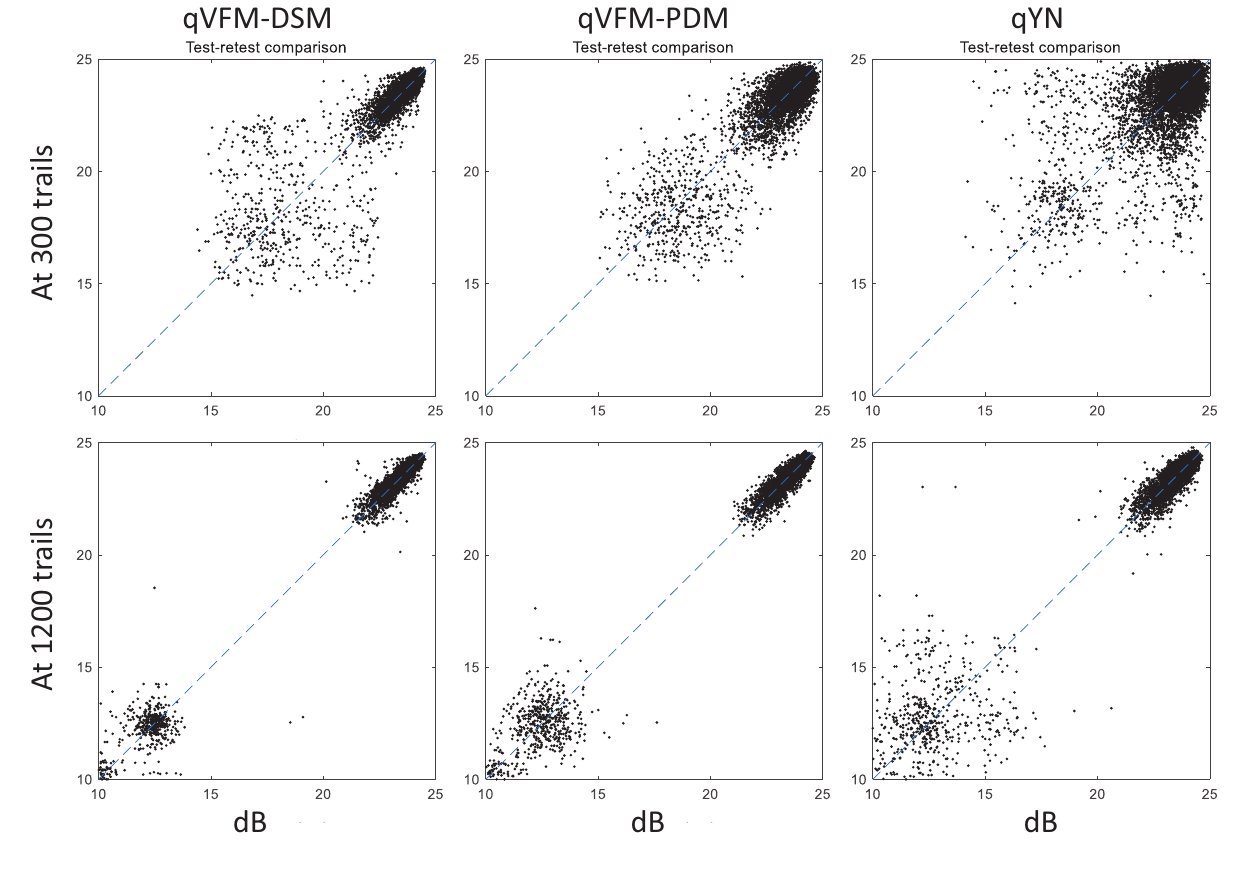
Frontiers in Neuroscience |